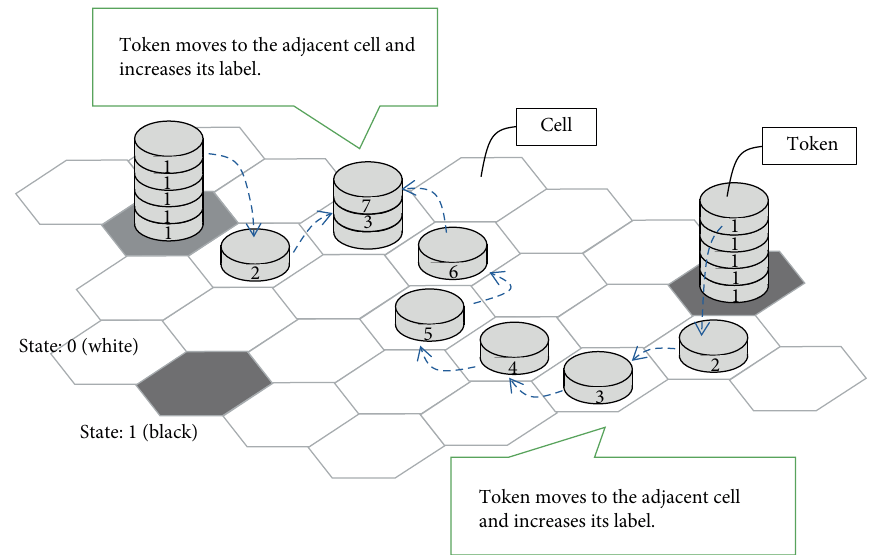
Figure 2: Schematic of the model and simulated space. Here, a two-dimensional hexagonal grid is used. Two-state cells (black and white) are assumed. The illustration shows the modification process of the tokens that are produced in the black cells. The number labeling the token is modified up to 𝑋 times in each cell, and some tokens remain in their cells without modification. The frequency distribution of token numbers determines the subsequent state of each cell. Here 𝑋 is the maximum number that can be attached to a token and is a positive